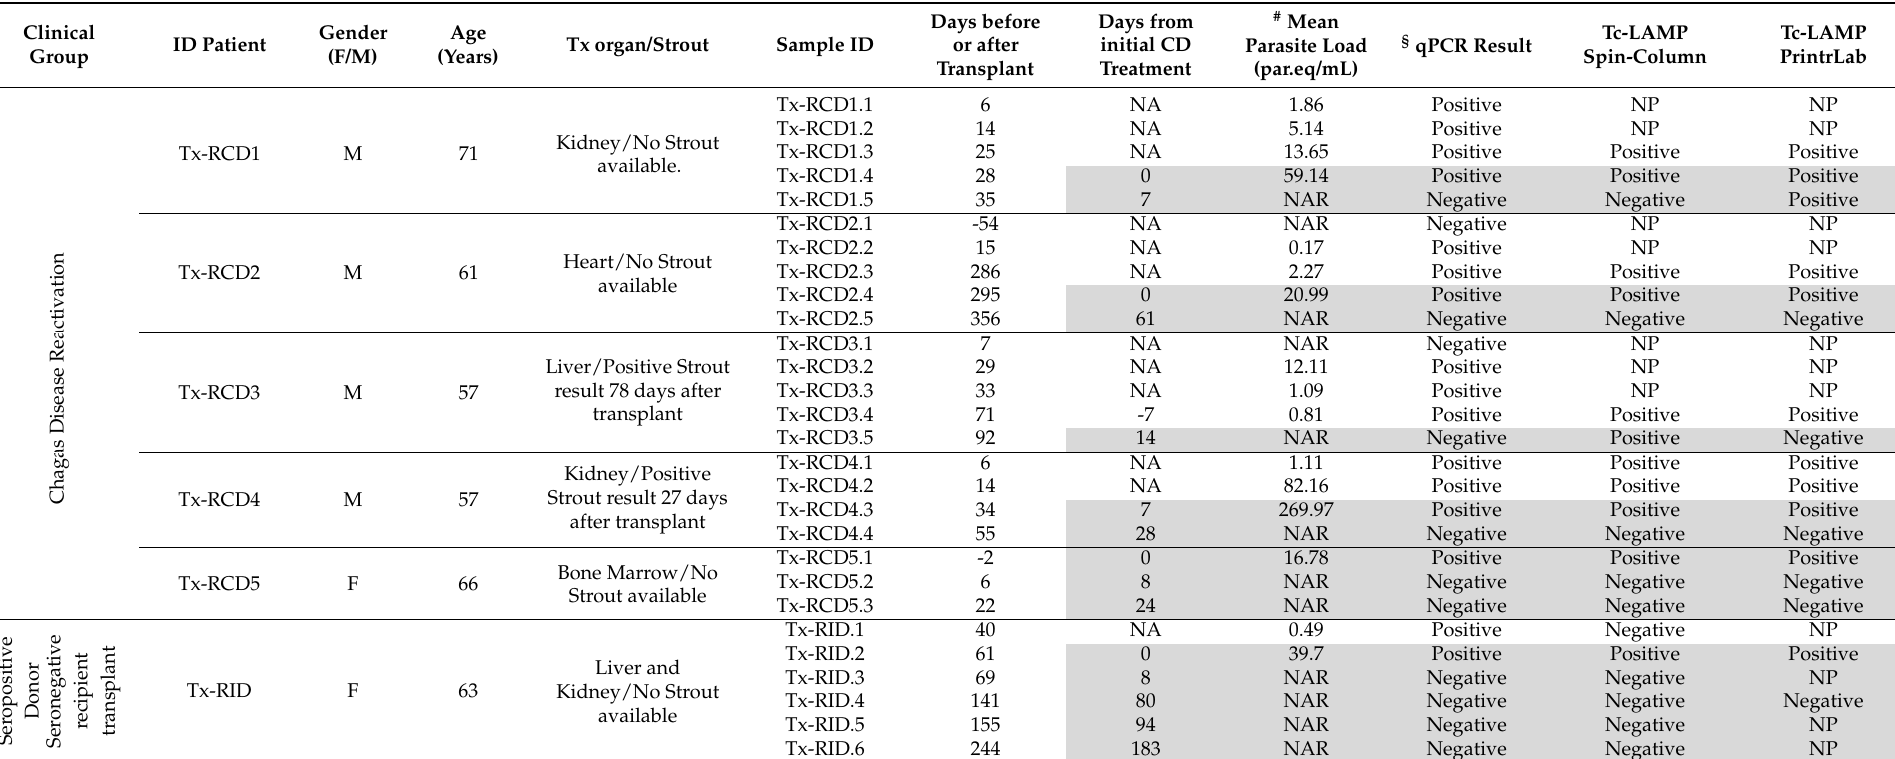
Table 2. Follow-up of Tx-RCD and Tc-RID clinical groups by qPCR and